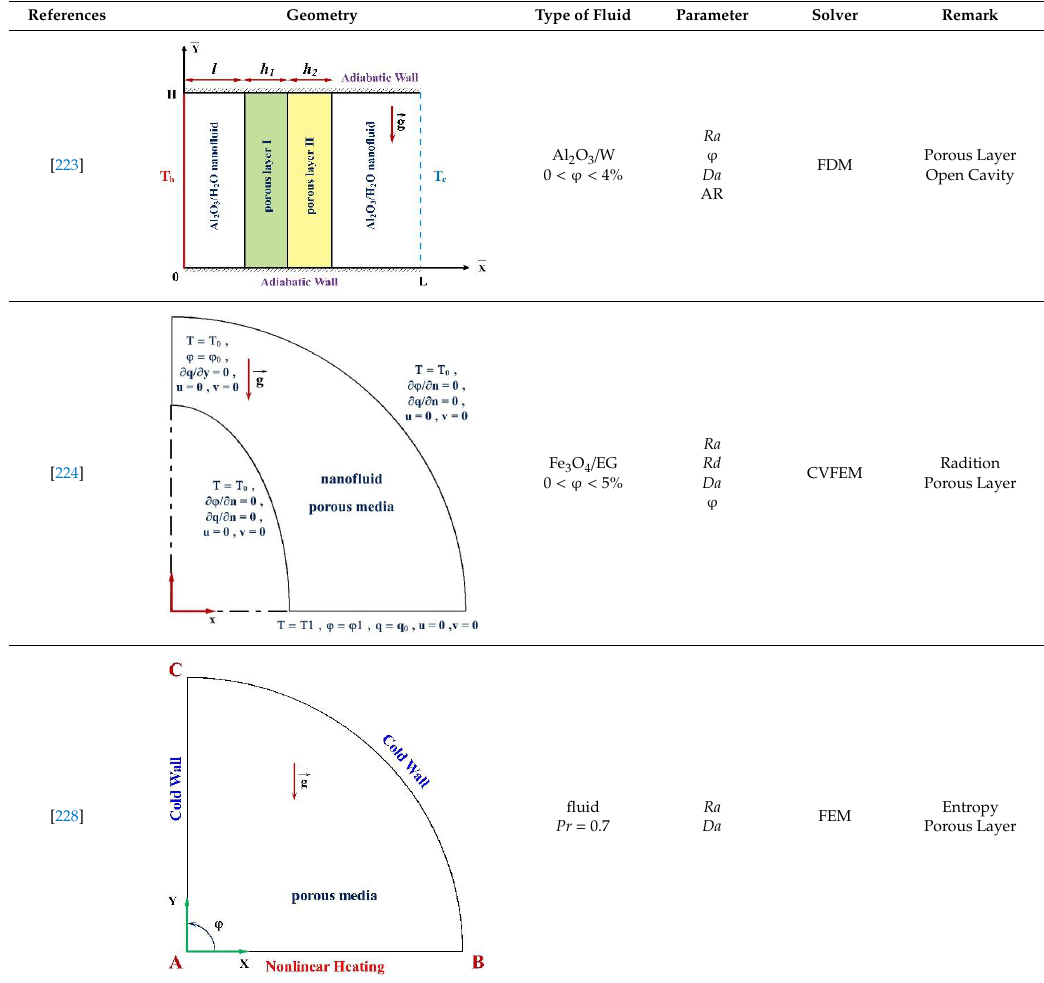
Table 11. Summary of some articles related to heat transfer in enclosures saturated with porous media.